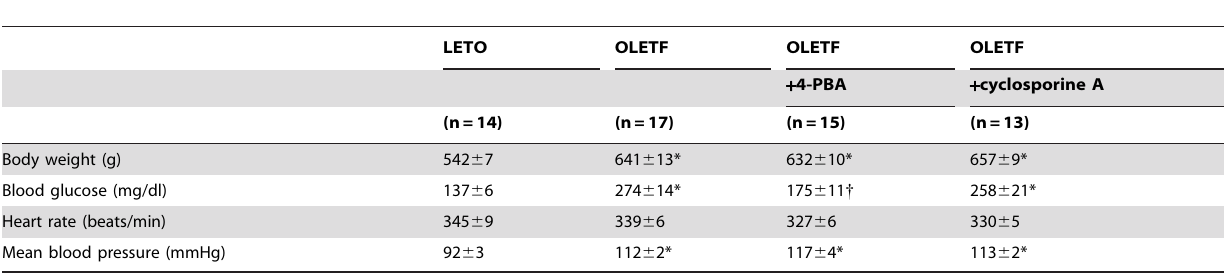
Table 1. Body weight, hemodynamics and blood glucose level.